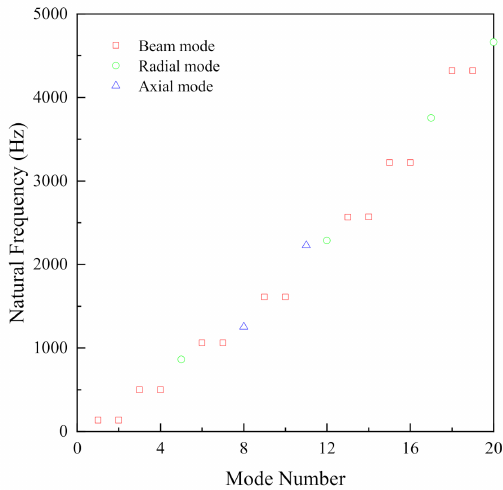
Figure 17. Natural frequencies of the multi-stage orifice and the connecting pipe. Energies 2020 , 13 , x FOR PEER REVIEW